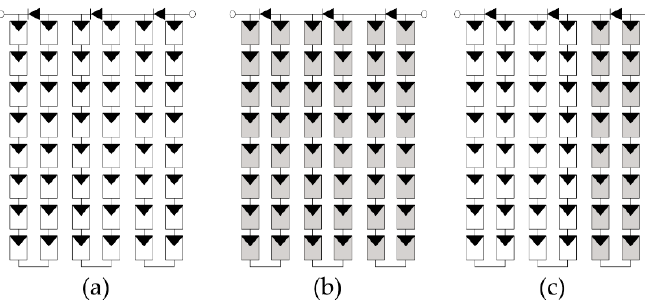
Figure 1. ( a ) Schematic diagram of a PV panel without shading; ( b ) a PV panel with a uniform irradiance pattern; and ( c ) a PV panel with a non-uniform irradiance pattern.